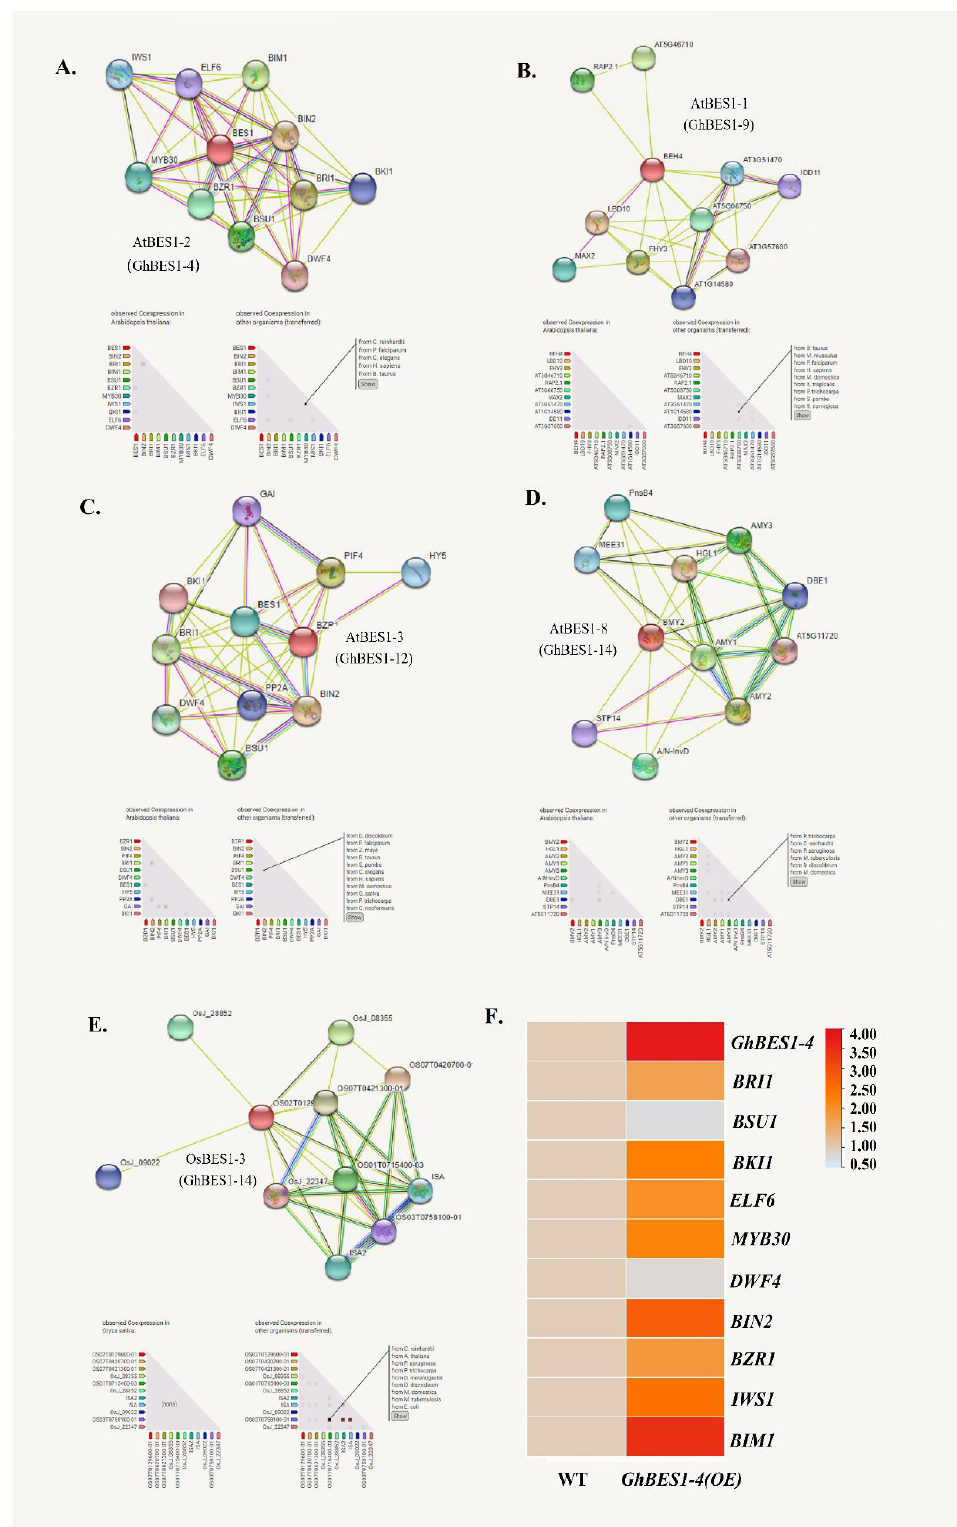
Figure 7. ( A – E ) Protein interaction of AtBES1 and OsBES1; the two gene ids next to the central protein are Arabidopsis or rice BES1 ids and their homologous genes in G. hirsutum. ( F ) The expression pattern analysis of AtBES1-2 interacting